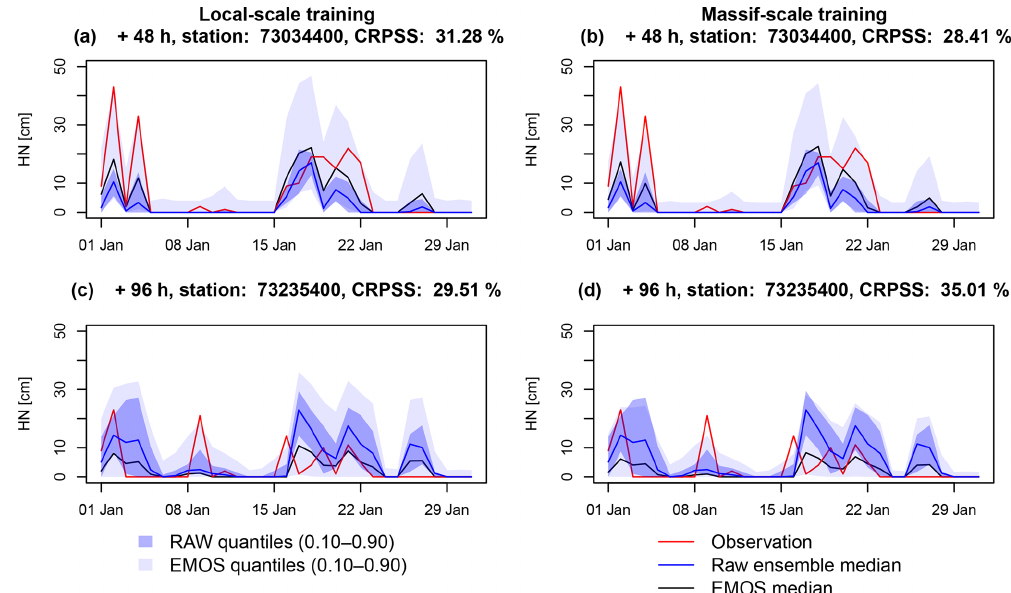
Figure 5. Time series of the raw (blue) and post-processed (grey) ensemble forecasts during January 2018 from a training based on the snow reforecasts. The envelopes represent the interval between the 10th and 90th percentiles and the solid lines represent the median. These ensemble forecasts are compared to time series of HN observations (red lines). (a, b) Example of station 73034400 (Arêches) at the + 48h lead time. (c, d) Example of station 73235400 (Saint-François-Longchamp) at the + 96h lead time. (a, c) Local-scale training. (b, d) Massif- scale